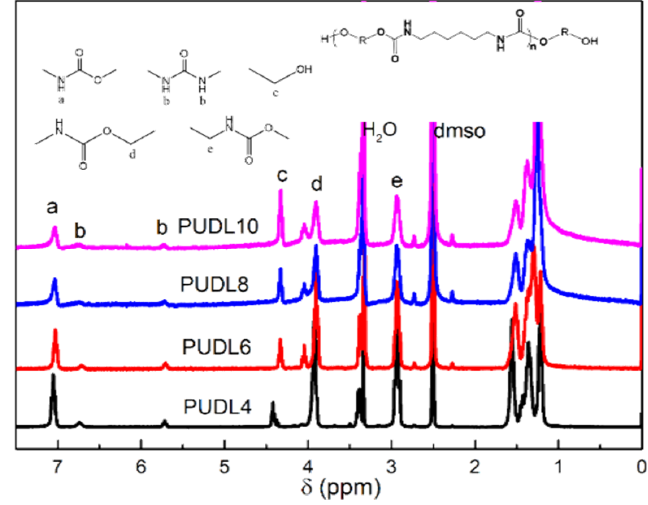
Figure 2. 1 H NMR spectra of PUDL.